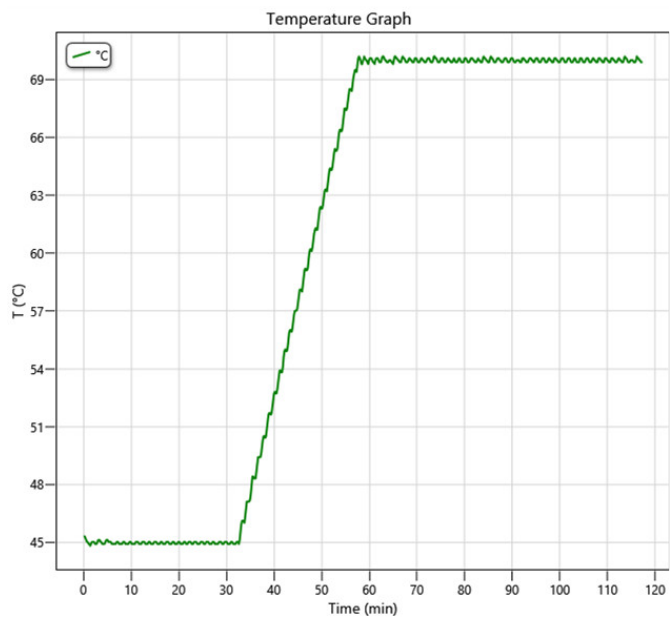
Figure 1. Congress mashing.